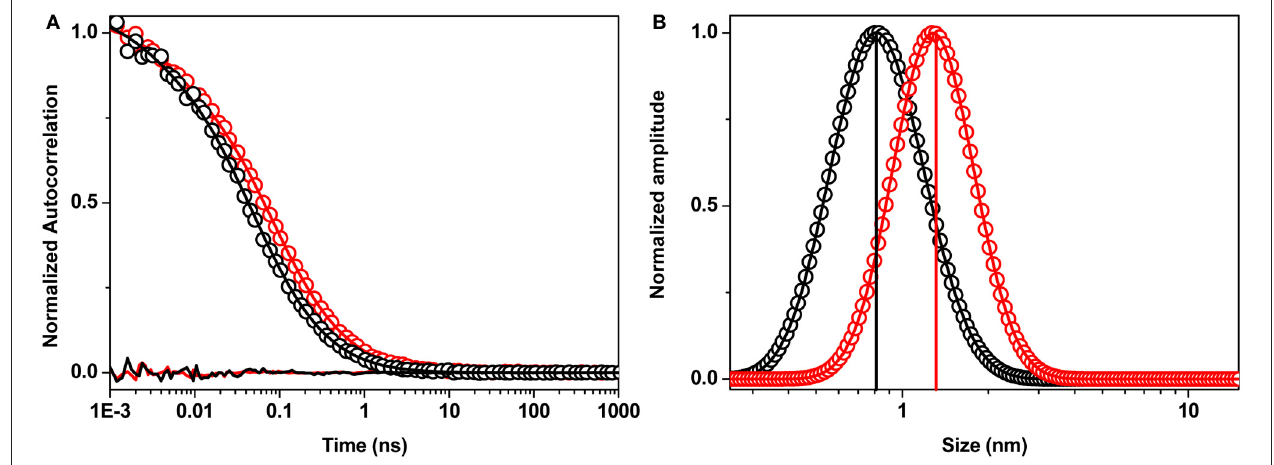
FIGURE A1 | Size of A β aggregates. (A) Fluorescence correlation spectroscopy data (circles) of A β 40 monomers (190 days old, black) and small oligomers (30min old, red). MEMFCS fit (solid line) and residuals (below the curve) are shown in corresponding colors.